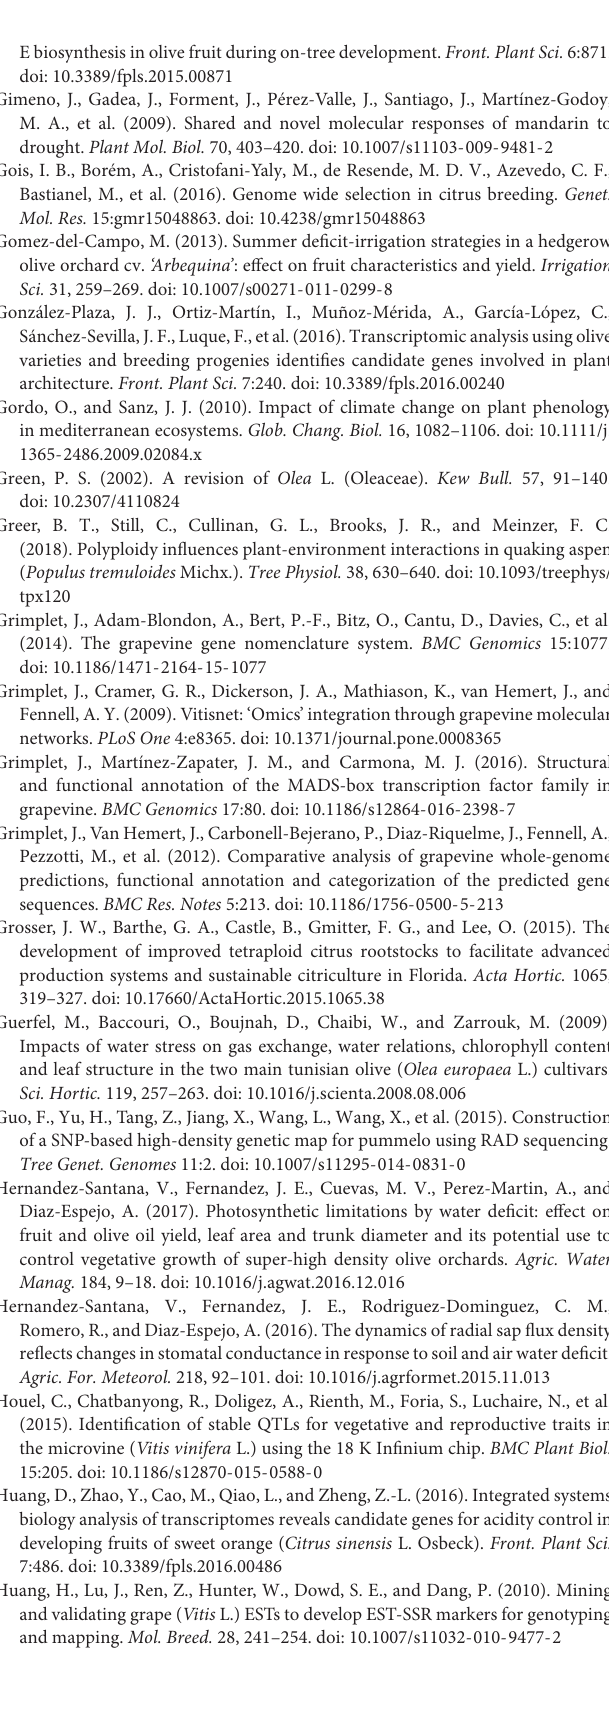
Frontiers in Plant Science |